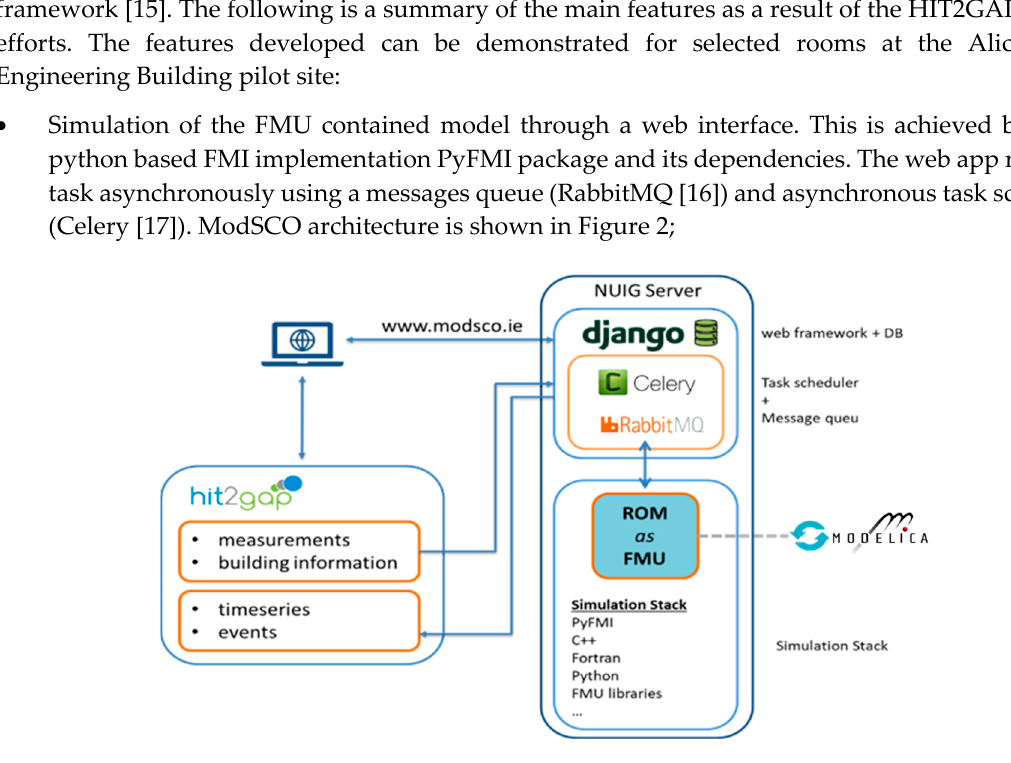
Figure 2. The ModSCO application